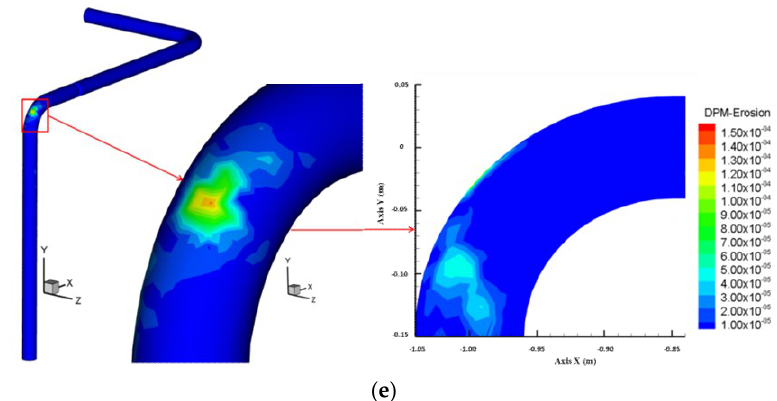
Figure 6. Erosion rate contours of gas–solid two-phase flow pipeline under different pressures. ( a ) pressure being 1.0 MPa ( P = 1.0 MPa); ( b ) pressure being 2.0 MPa ( P = 2.0 MPa); ( c ) pressure being 3.0 MPa ( P = 3.0 MPa); ( d ) pressure being 4.0 MPa ( P = 4.0 MPa); ( e ) pressure being 5.0 MPa ( P = 5.0 MPa).